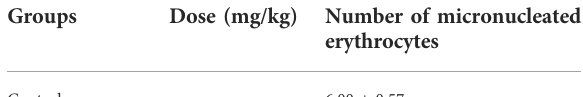
TABLE 1 Micronucleus test in peripheral blood of mice treated with a single dose of ACS-AZ or cyclophosphamide.